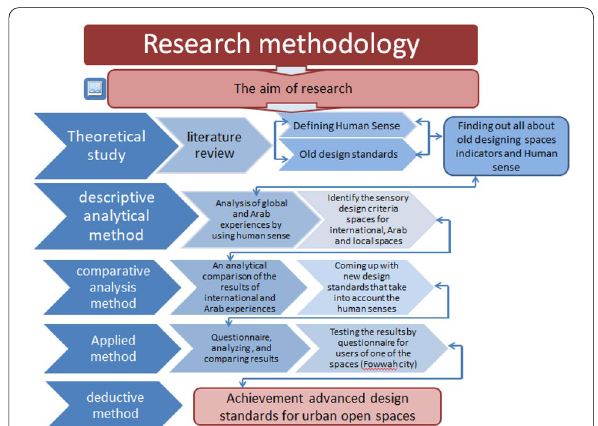
Fig. 1 The research methodology, Source: The